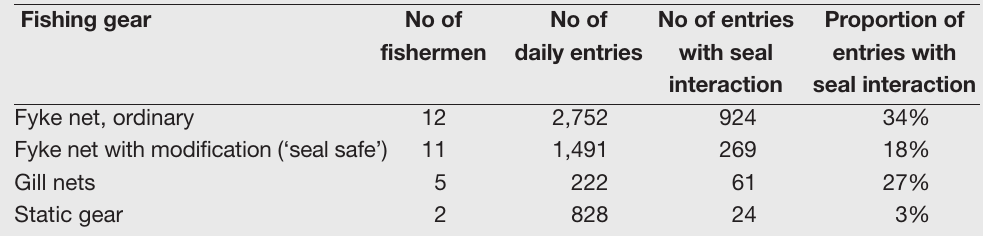
Table 1. Compilation of reported seal damage in the voluntary logbook, including the num- ber of reports during 2001 to 2006. Fyke nets are used for eel fishery, gill nets are different forms of bottom-set nets and static gear is large traps targeting salmon and eel. Fishing gear No of No of No of entries